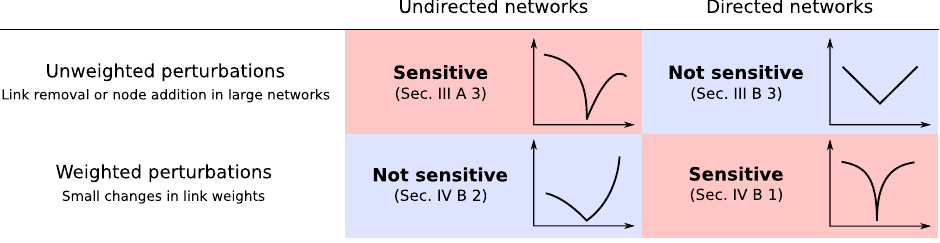
FIG. 1. Directed and undirected networks optimized for the stability of the network dynamics can be sensitive to weighted and unweighted structural perturbations, respectively. The graphs schematically illustrate typical behavior for systems with sensitivity (in red boxes) and systems with no sensitivity (in blue boxes). Under weighted perturbations, we actually show that all undirected networks (including nonoptimal ones) are nonsensitive (lower blue